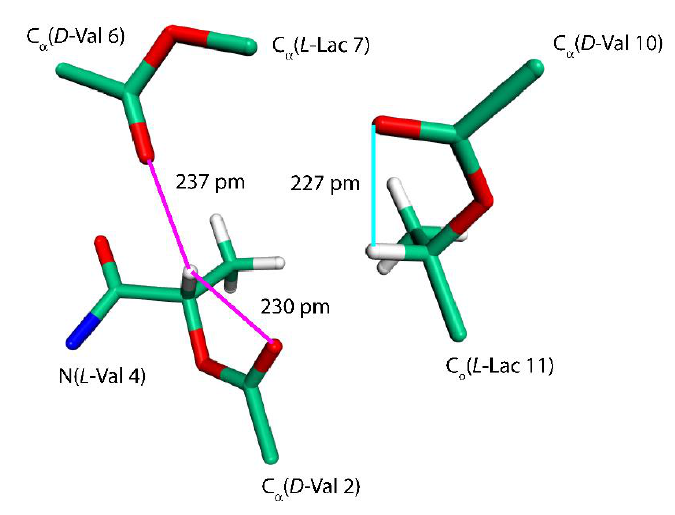
Figure 5. The fragment of a VLM molecule of the “propeller” polymorph. See the text for details.